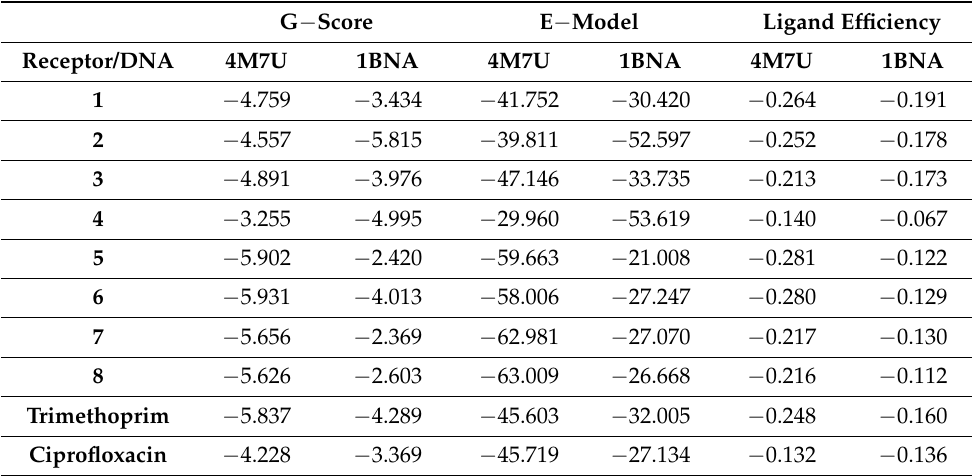
Table 6. Energies of Schiff bases ( 1 – 4 ) and α -unsaturated amino carboxylic acids ( 5 – 8 ) with enzyme E.faecalis DHFR (4M7U) and B-DNA dodecamer